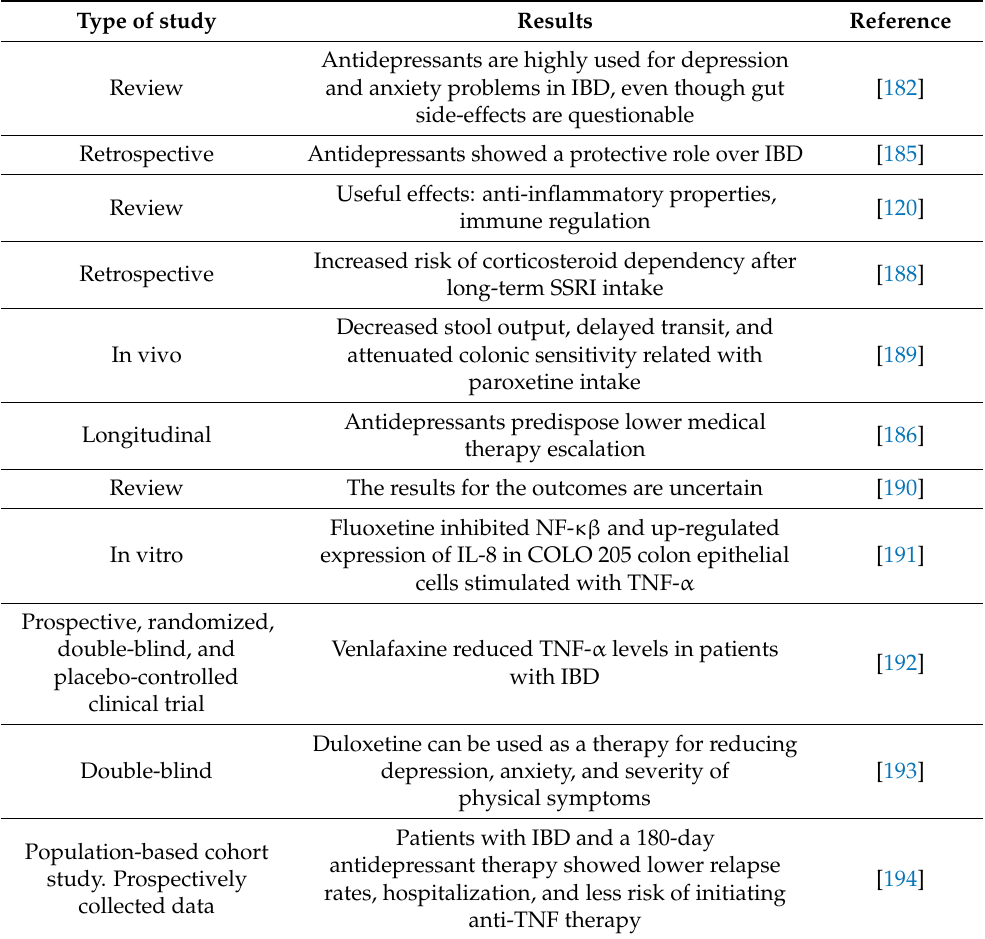
Table 4. Scientific evidence regarding the use of selective serotonin re-uptake inhibitors in patients with inflammatory bowel